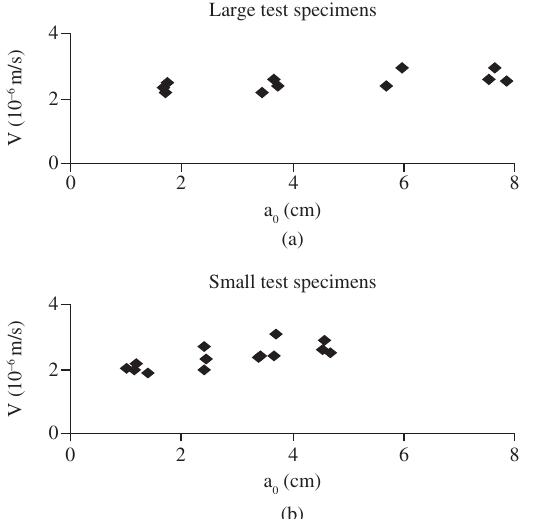
Figure 7. Critical crack length, a specimens, and b) for small test specimens.